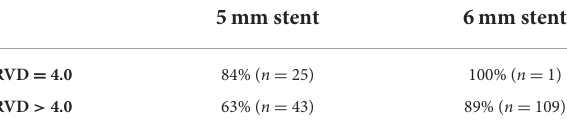
TABLE 3 Patency rates by stent size and vessel diameter. 5mm stent